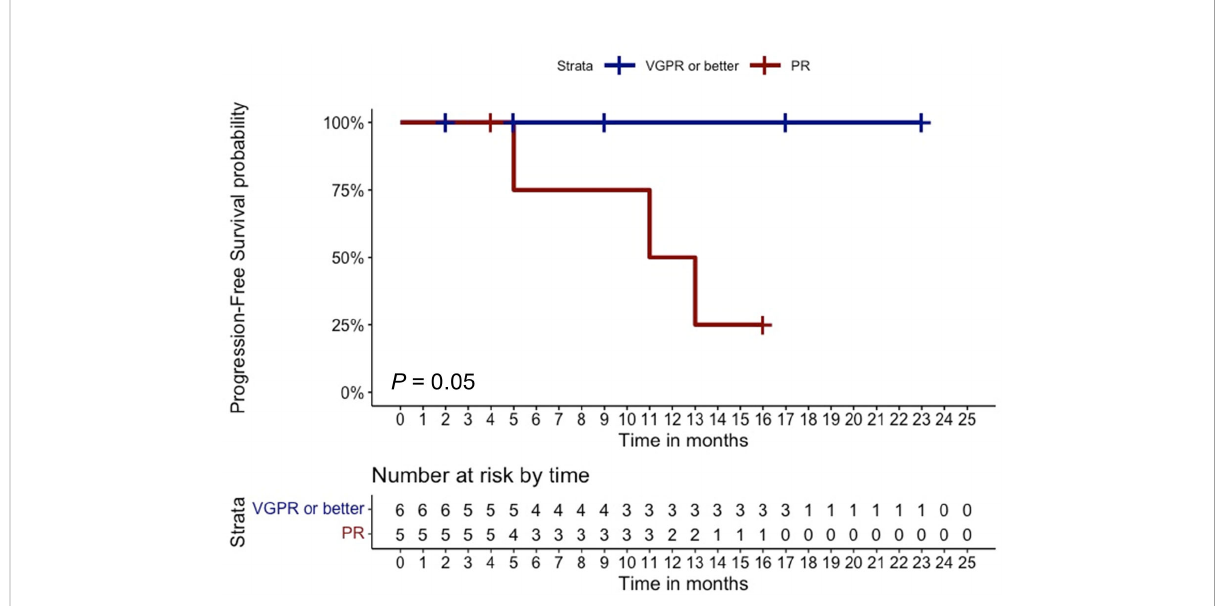
FIGURE 2 Clinical outcomes based on overall response. Progression-free survival of multi-refractory/relapsed multiple myeloma patients who achieved at least a very good partial response (VgPR) was compared to that of subjects who achieved a partial remission (PR). The number of censored subjects at risk is also reported. A P < 0.05 was considered statistically signi fi cant.